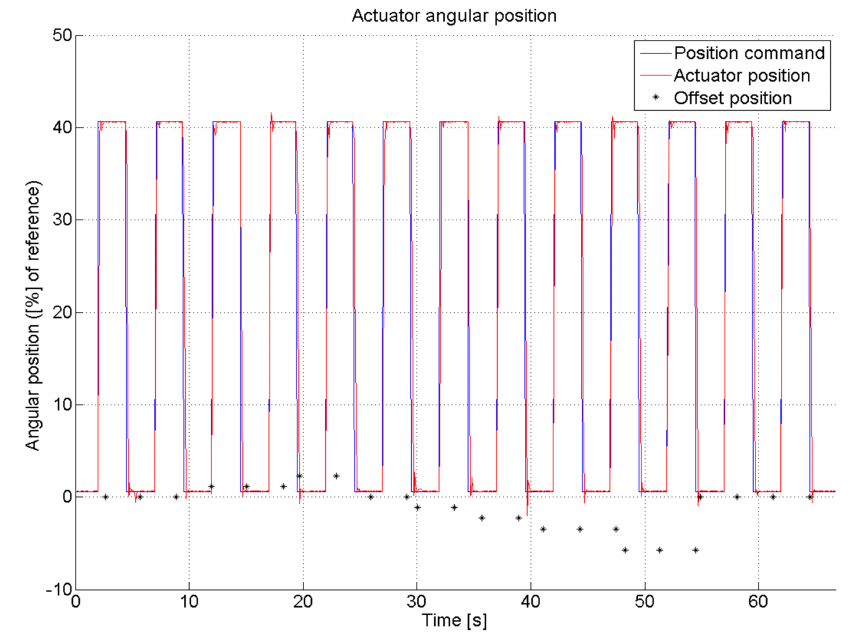
Figure 14. Position response in faulty